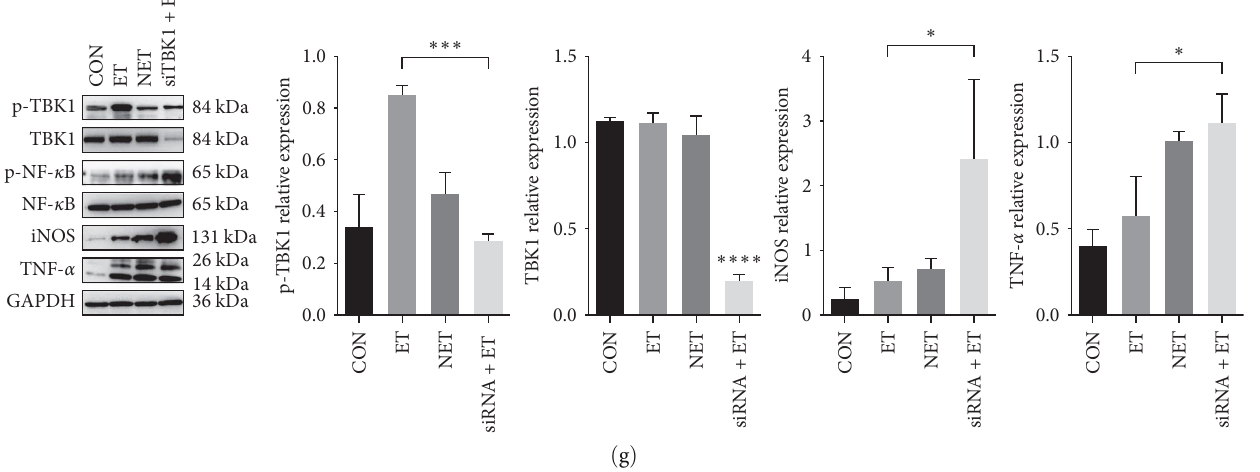
F IGURE 1: Effect of TBK1 on endotoxin tolerance in KCs in vitro: (a) KCs were randomly divided into three groups. Western blotting was